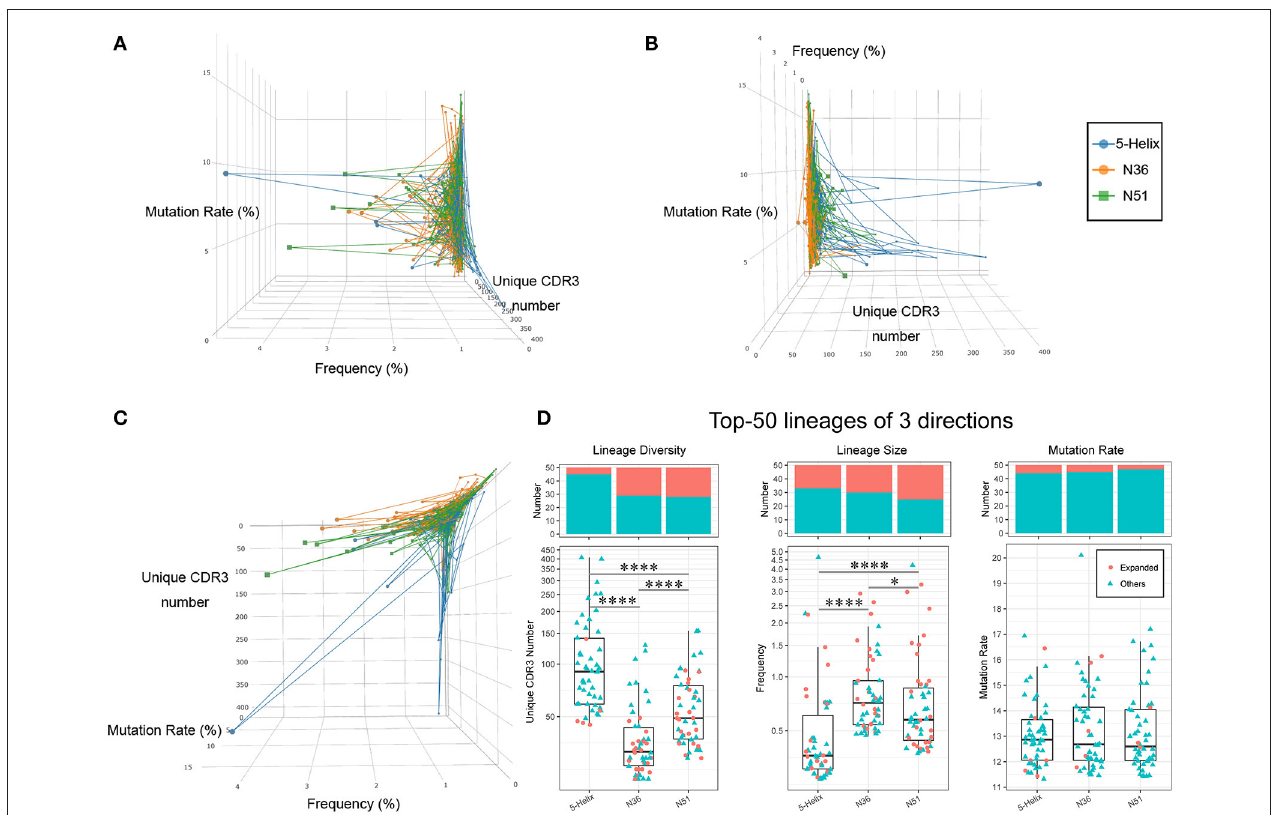
FIGURE 6 | Three vaccines modulate different IGH lineage features. The high abundance lineages ( > 0.05%) in each sample are plotted in a 3-dimensional space, the 3 axes of which represent the lineage diversity, the lineage size(abundance) and the average mutation rate, respectively. Lineages from different groups are connected and labeled in three different colors (left: blue, orange, green) (A). Projection of lineage diversity axis (B). Projection of lineage size axis (C). Projection of average mutation rate axis (D). Lineage diversity (left panel), lineage size (middle panel), and average mutation rates (right panel) of the top 50 lineages from each vaccination groups are illustrated as boxplots. The histogram plots on the top demonstrates the proportion of vaccination-induced